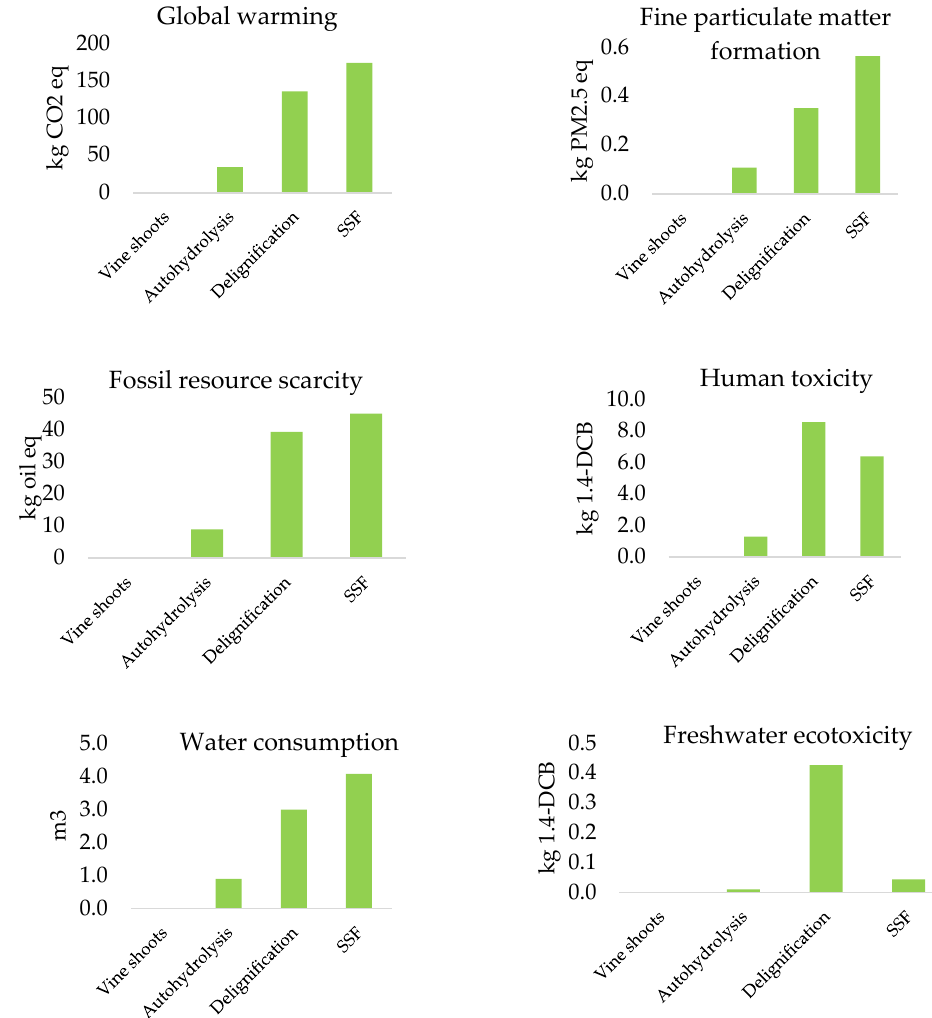
Figure 4. Characterization of the impact categories of bioethanol production stages.